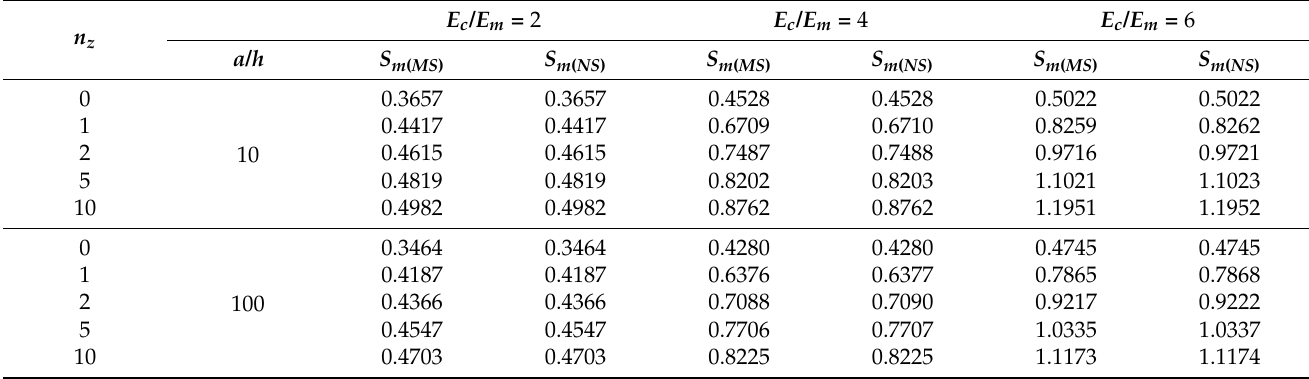
Table 4. Non-dimensional deflection w of a BDFG square movable simply supported plate subjected to sinusoidal load based on neutral surface formulation S m ( MS ) and middle surface formulation S m ( NS ) at n x = 1 for different E c / E m and a / h ratios.